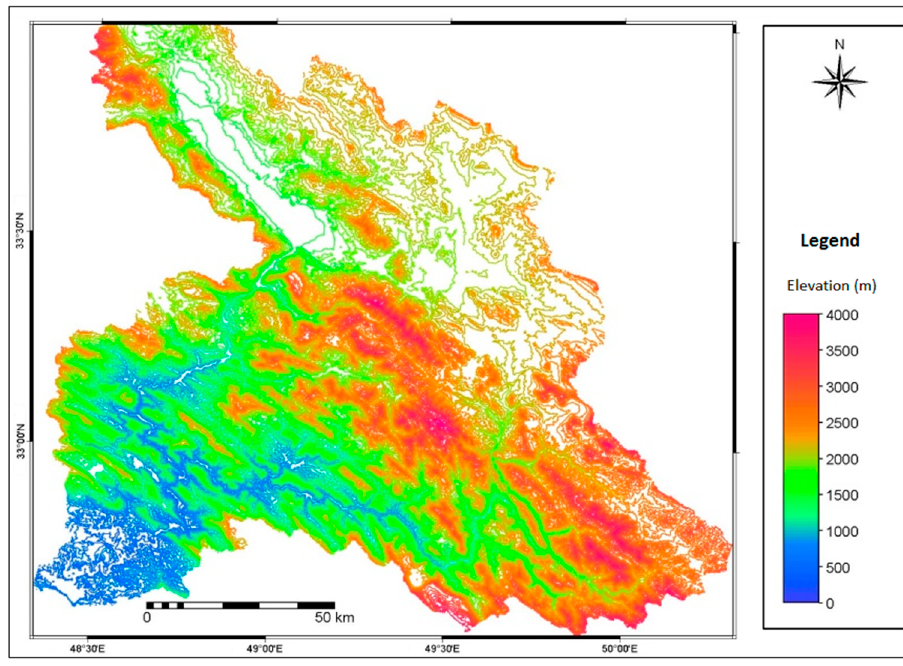
Figure 2. Elevation contour map of Dez Basin.